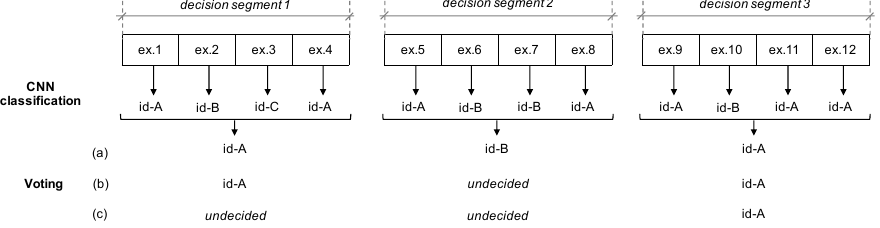
Figure 5. Example of the voting mechanism. Three different voting criteria are represented in this example: ( a ) first to plurality, ( b ) plurality, and ( c )